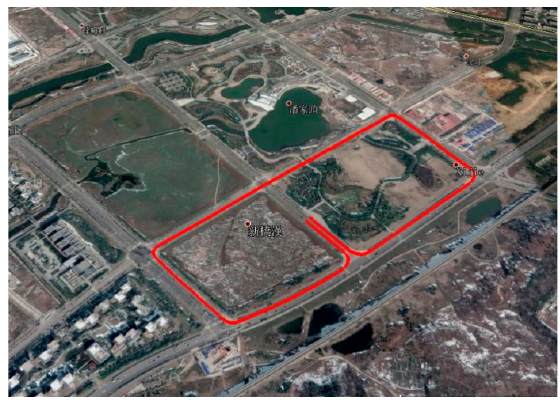
Figure 3. The trajectory of the experiment.